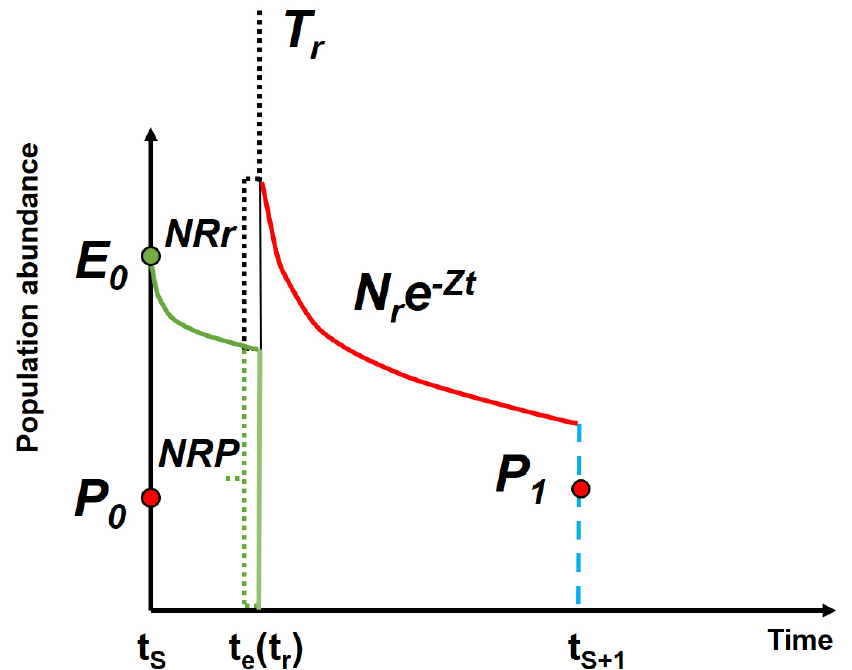
Figure 2. Map showing the schematic diagram of the assessment model.